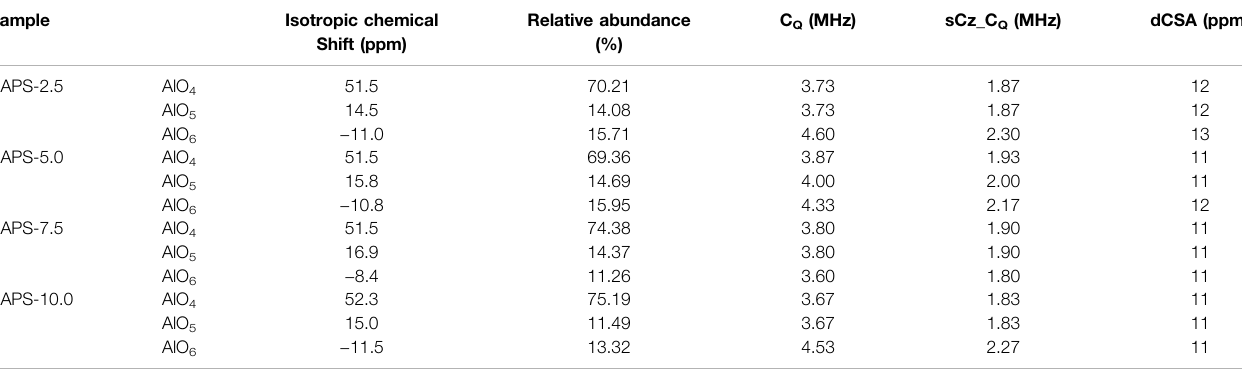
TABLE 4 | 27 Al MAS-NMR deconvolution parameters. sCZ_CQ represent the distribution of Quadrupolar coupling constant CQ. dCSA represents the distribution of isotropic chemical shift. Sample Isotropic chemical